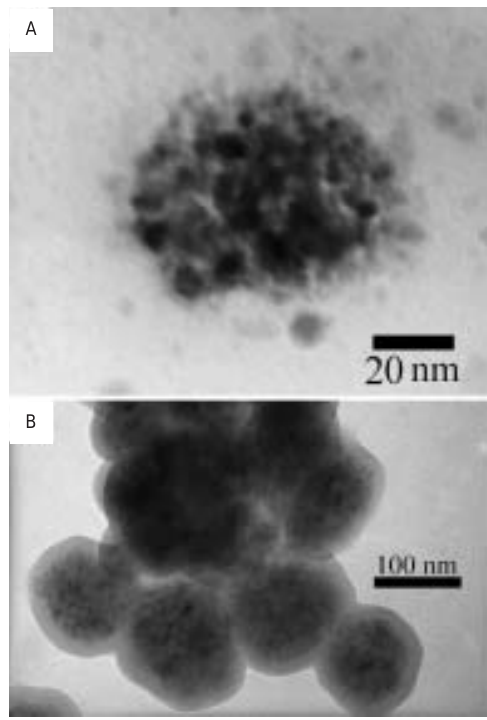
Fig. 3 TEM microphotograph of the sample containing 3.9 and 5.53 wt. % of Co nanoparticles (A, B, (cid:1) from acetate and formate, respectively) on the surface of PTFE nanogran-